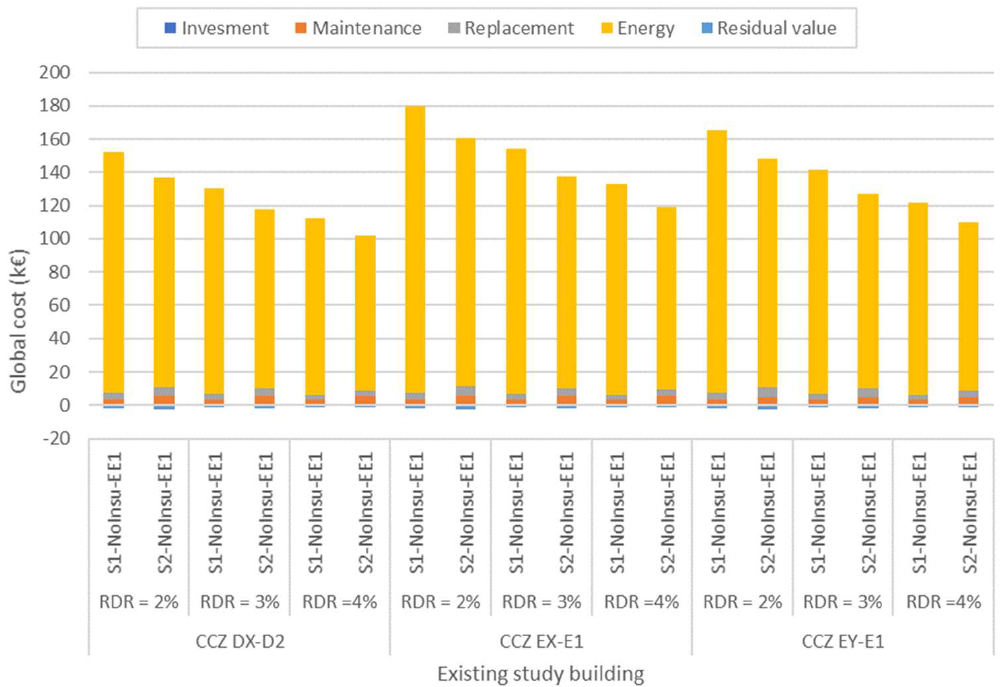
Figure 5. Global cost breakdown by the different costs and residual value, in EUR 1000, for each existing study building by CCZ and real discount rate (RDR).